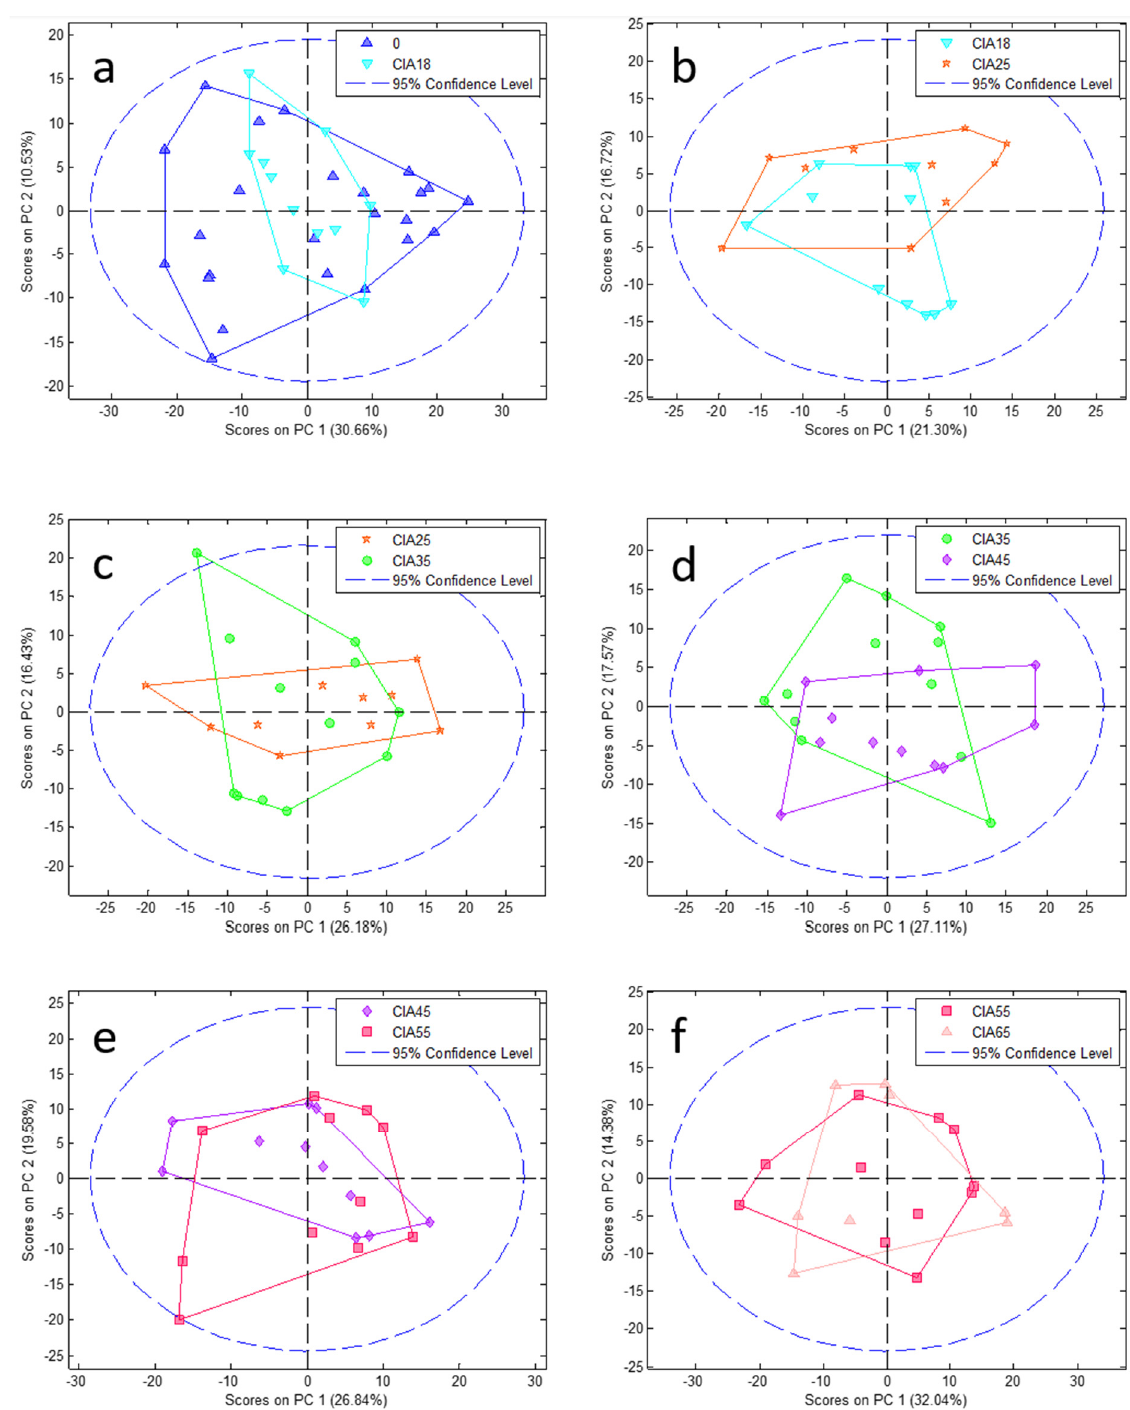
blue inverted triangle); CIA45: CIA group 45 days after disease induction (red star); CIA55: CIA group 55 days after disease induction (light blue circle); CIA65: CIA group 65 days after disease induction (light blue diamond); CO18: CO group 18 days after the beginning of the experiment (light pink square); CO25: CO group 25 days after the beginning of the experiment (green triangle); CO35: CO group 35 days after the beginning of the experiment (orange inverted triangle); CO45: CO group 45 days after the beginning of the experiment (blue star); CO55: CO group 55 days after the beginning of the experiment (purple circle); CO65: CO group 65 days after the beginning of the experiment (yellow diamond). LV: latent variable.